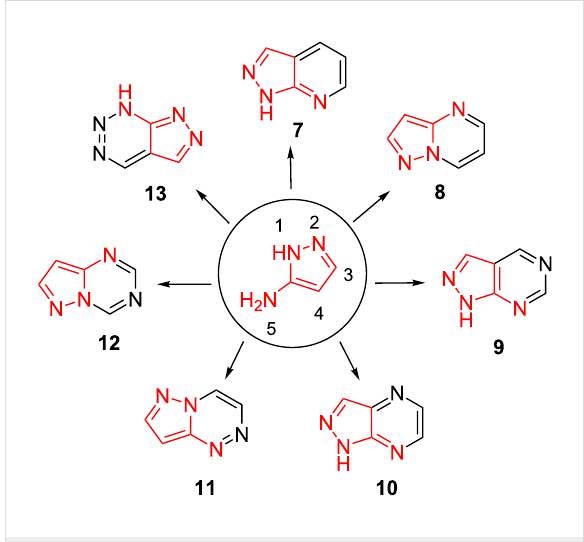
Figure 2: Typical structures of some fused pyrazoloazines from 5-aminopyrazoles.